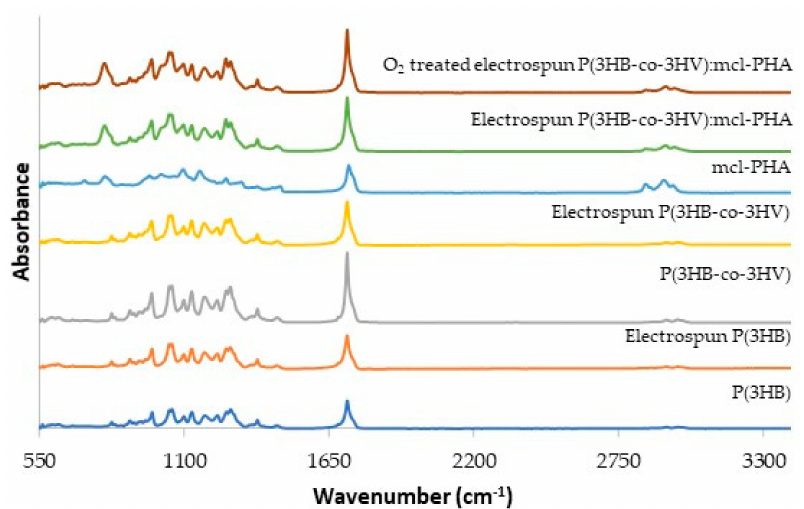
Figure 7. FTIR-ATR spectra of the biopolymers P(3HB), P(3HB-co-3HV) and the mcl-PHA, of the electrospun scaffolds made of P(3HB), P(3HB-co-3HV) and the P(3HB-co-3HV): mcl-PHA blend and of the oxygen plasma treated P(3HB-co-3HV): mcl-PHA blend